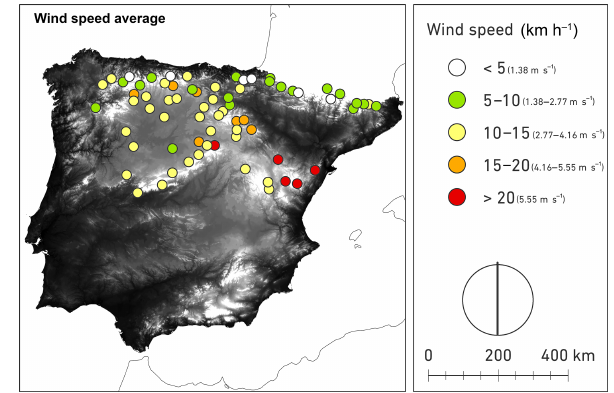
Figure 9. Average station wind speed during 1h snowfall events.